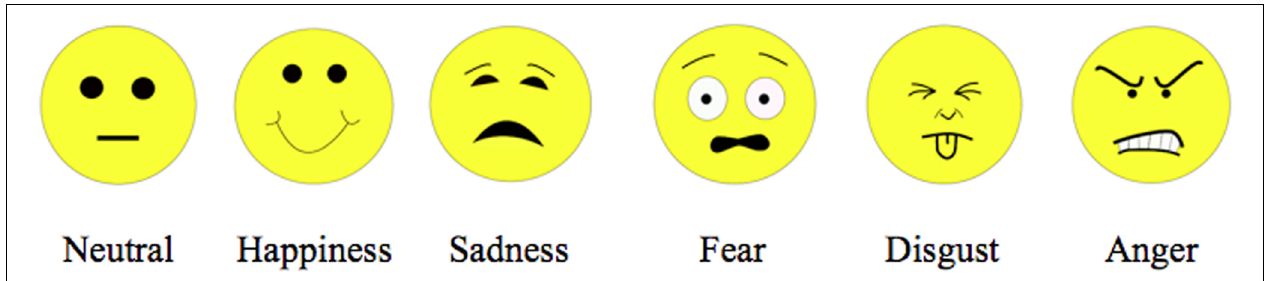
FIGURE 2 | Emotion